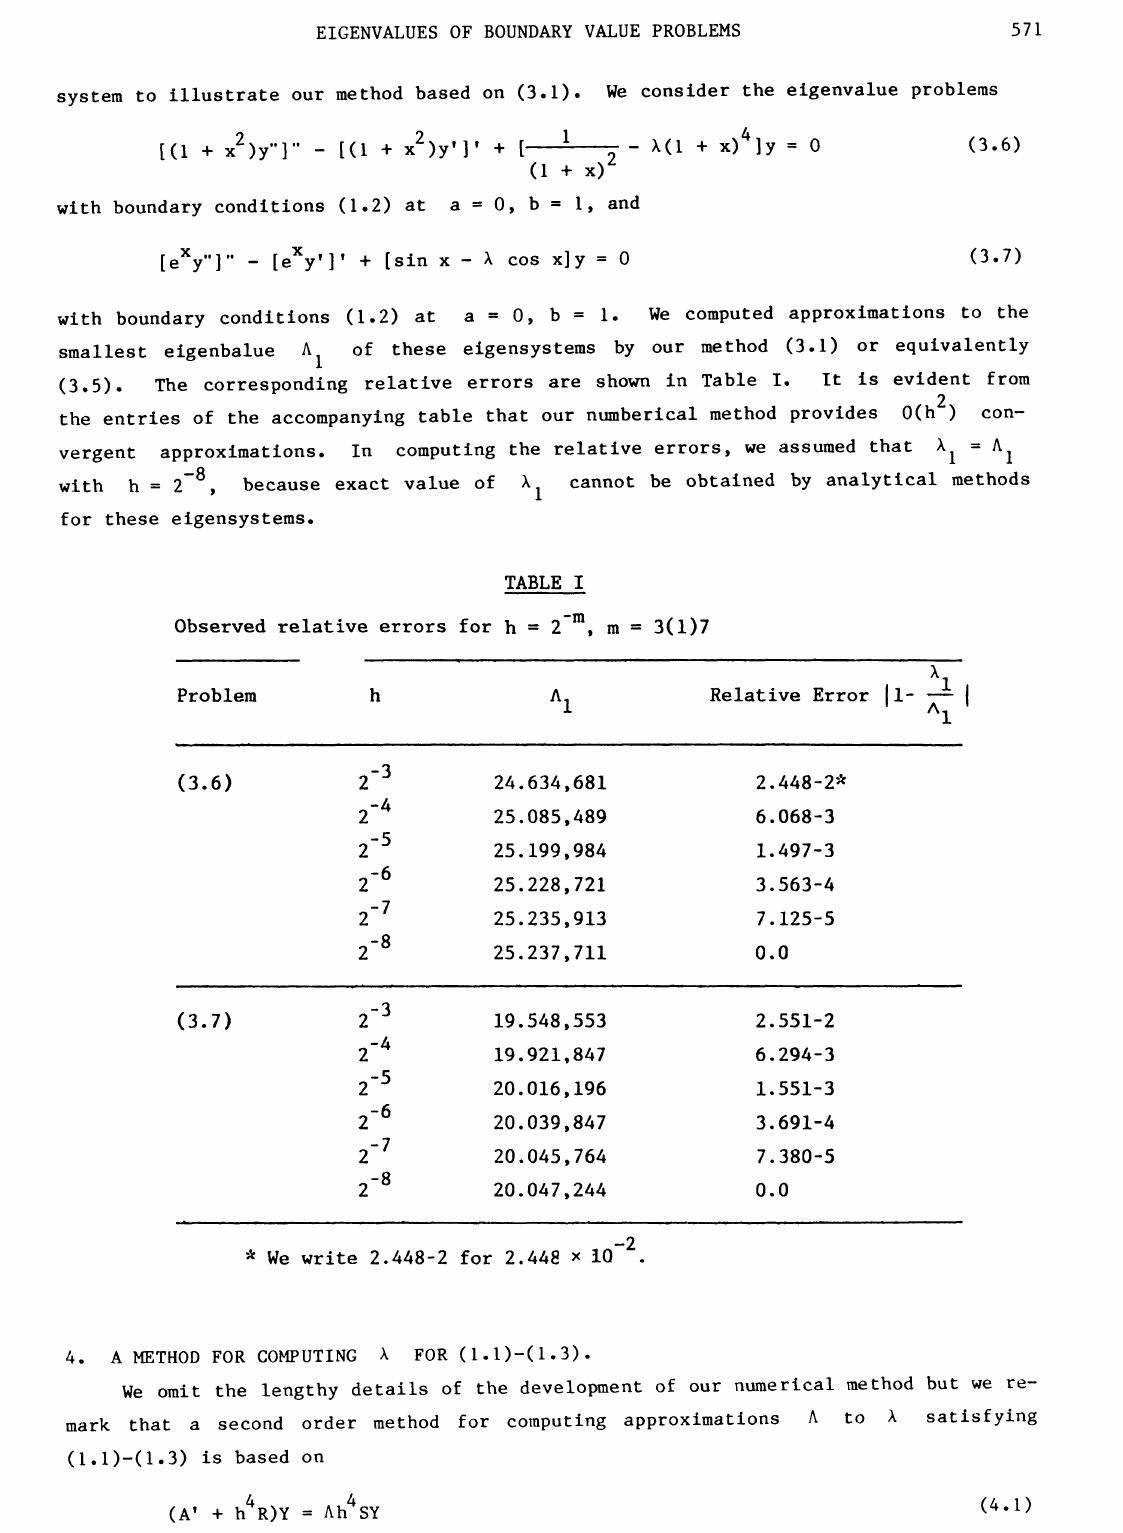
Observed relative errors for